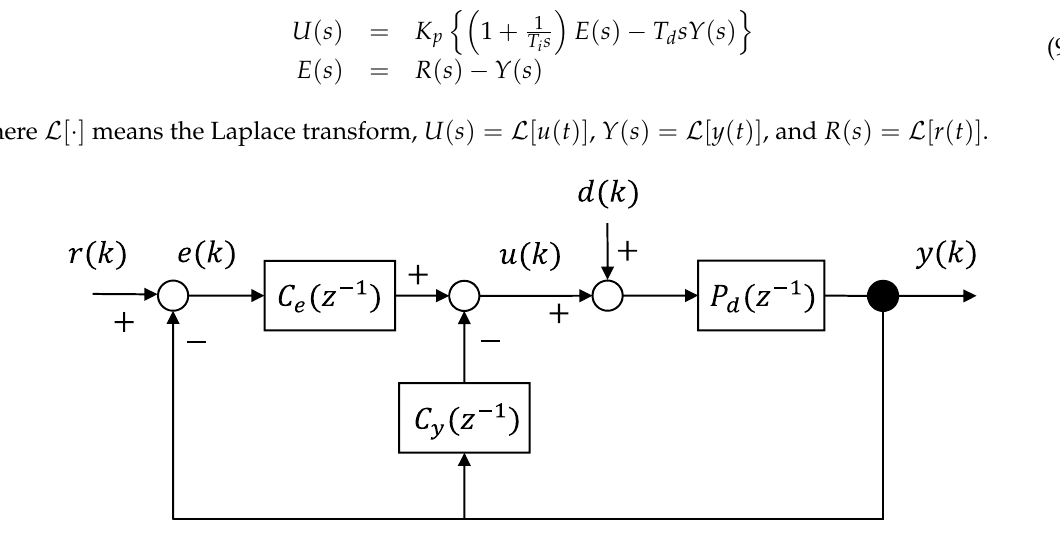
Figure 1. Discrete-time PID control